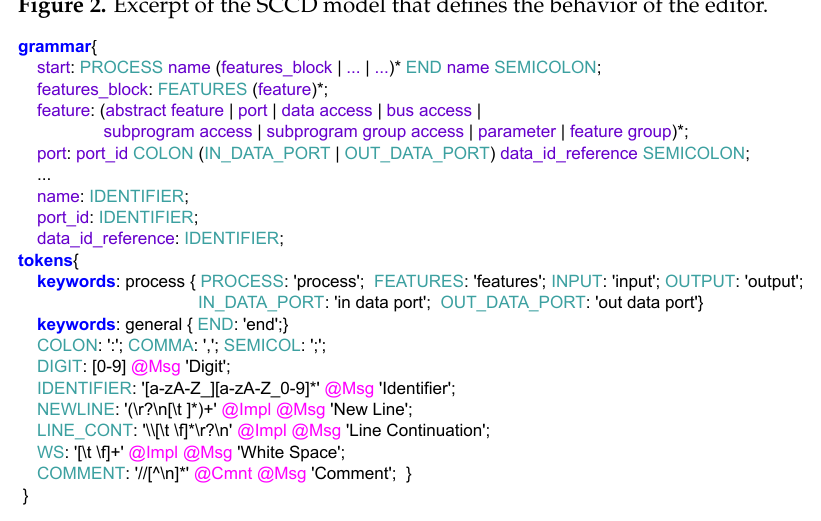
Figure 3. Simplified AADL process grammar (adopted from